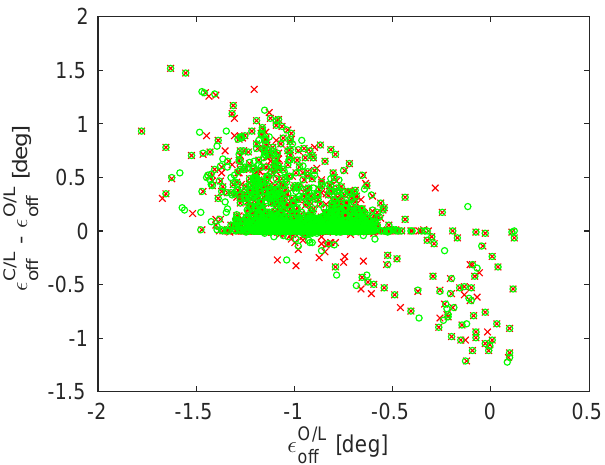
Figure 6. Observed carrier frequencies f obs , reconstructed from NCO and residual frequencies (Eq. 5), using external data bit de- modulation as a function of elevation angle (red and green). In ad- dition, the closed-loop result is plotted in blue. For clarity, a con- stant offset f ref = 1 . 4071MHz is subtracted. Same event as shown in Figs. 2 and